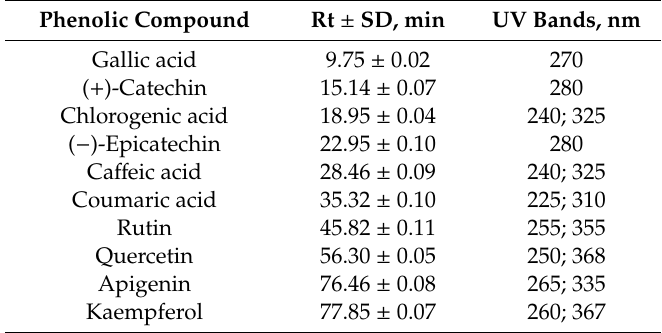
Table 3. Chromatographic and spectroscopic parameters of phenolic